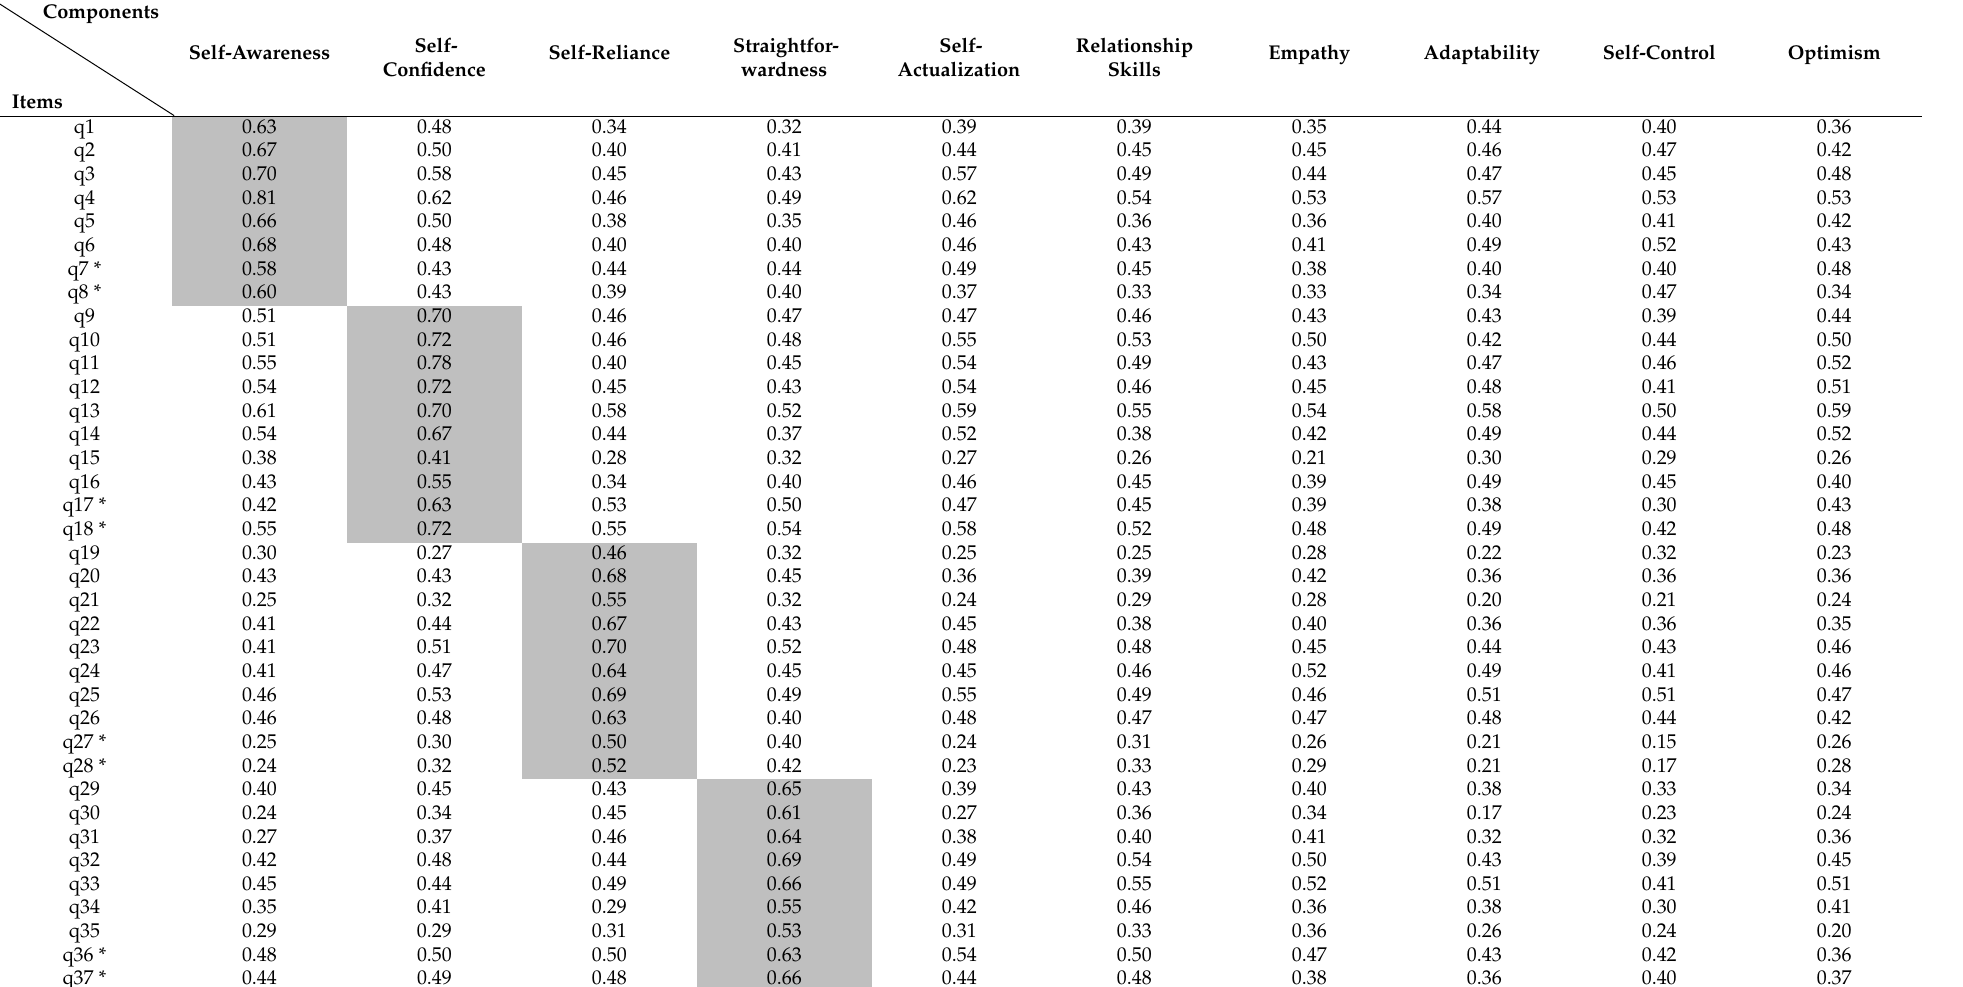
Table 4. Cross loading